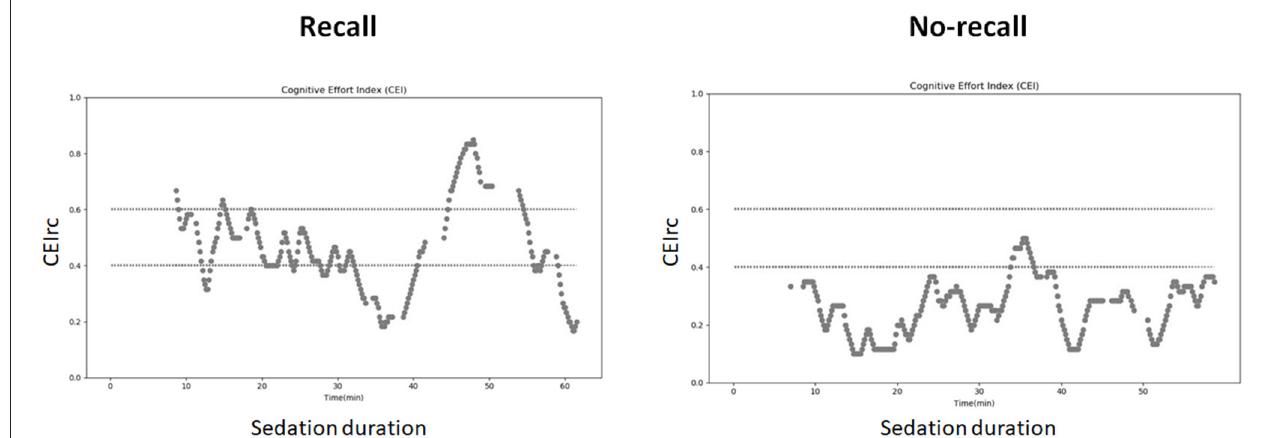
FIGURE 2 | CEIrc dynamics under sedation. Left: a patient with recall; Right: patient without